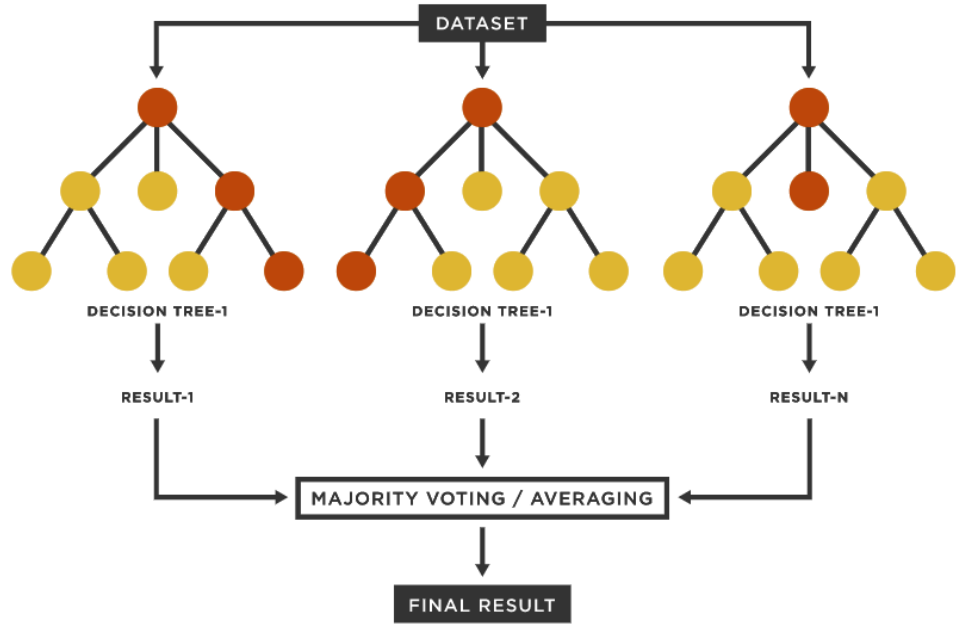
Figure 4. Ensemble-technique-based classification